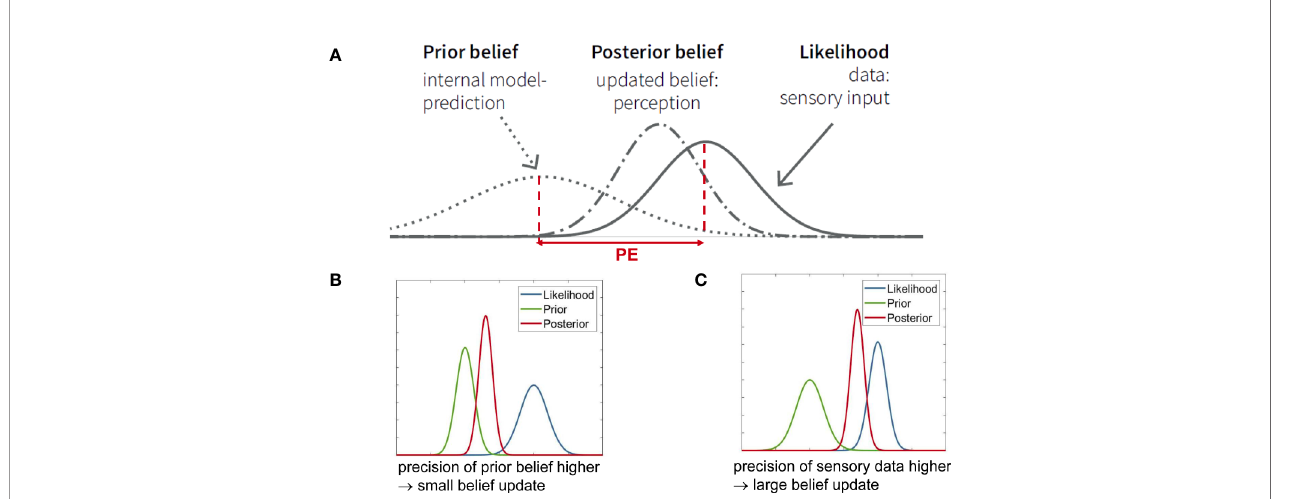
FIGURE 2 | (A) Graphical summary of Bayes ’ theorem (see Eq. 1) for the case of Gaussian probability distributions. It illustrates that the posterior represents a compromise between prior and likelihood, depending on their relative precision. PE is the abbreviation for “ prediction error. ” To revisit the example from Figure 1B, let us consider perception of temperature. The actually perceived temperature (posterior belief) is a compromise between the expected or predicted temperature (prior) and the sensory input (likelihood). The posterior belief can also be understood as updating the prior belief, where the magnitude of the belief update depends on the prediction error (PE) and the relative precisions (inverse variance) of the prior and the likelihood. In this example, the precision of sensory input (likelihood) is higher, therefore the posterior is closer to the likelihood. This panel is adapted from Figure 2 in Haker et al. (82), with permission. (B) When the precision of the prior belief is higher than the precision of the data (likelihood), a small belief update results, i.e., the posterior stays close to the prior. (C) When the precision of the data (likelihood) is higher than the precision of the prior belief, a large belief update results, i.e., the posterior moves more strongly towards the data.